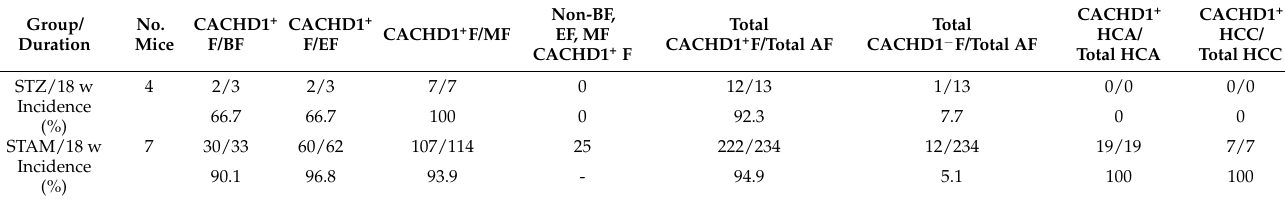
Table 3. Incidences of CACHD1-positive and negative preneoplastic and neoplastic lesions in the livers of 18-week-old STAM and control STZ